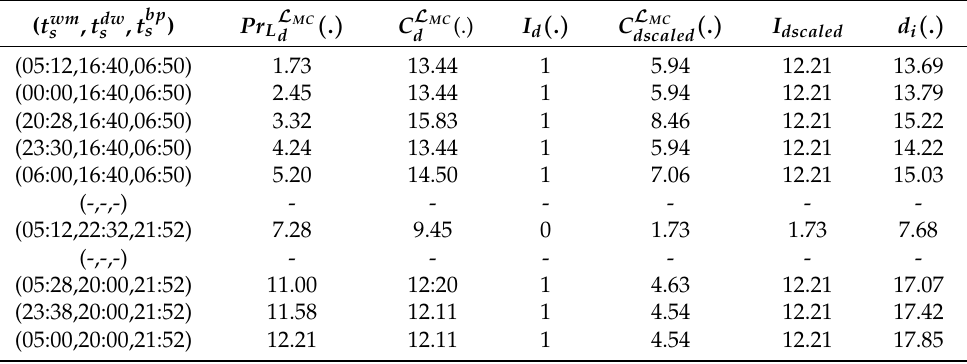
Table 7. For the possible triplets of starting times; priority level, electricity cost, power limit indicator, scaled priority level, scaled power limit indicator values and the corresponding values of objective function of BFCP Algorithm (Algorithm 2) for Scenario 1.